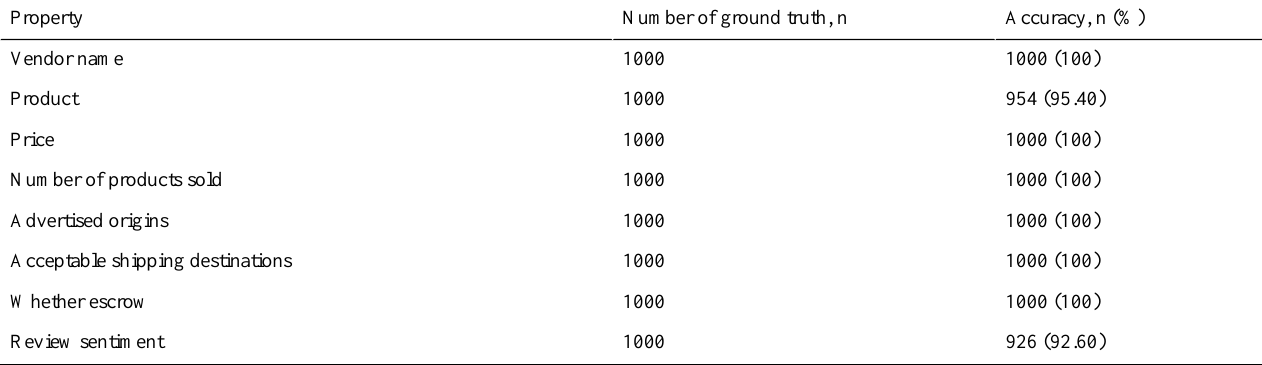
Table 5. The results of calculating accuracy of opioid information